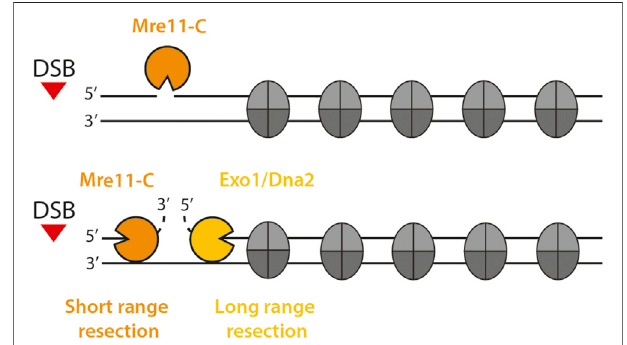
FIGURE 1 | Eukaryotic DNA end resection in the chromatin context. DNA end resection is a two step process that can be divided into short-range resection (orange) and long-range resection (yellow). Mre11-C initiates short- range resection by nicking the 5 ′ terminated strand in proximity to the DSB viaitsendonucleaseactivity.Then, Mre11-Cgeneratesashort 3 ′ ssDNA overhang close to the DSB using its 3 ′ -5 ′ exonuclease function. Exo1 and STR-Dna2 carry out long-range resection and extend the length of the resected ssDNA tract through chromatin.